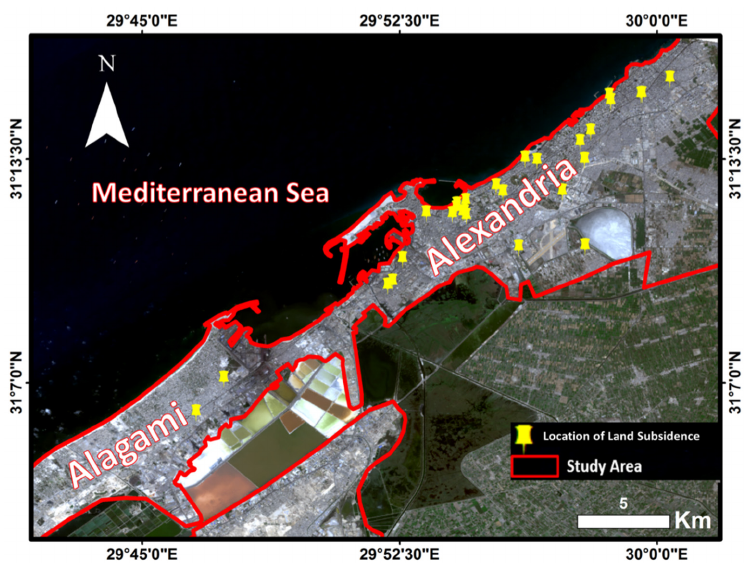
Figure 1. The urban study area in Alexandria City is outlined with a red border plotted on a Sentinel-2 image of October 2019. The yellow dots represent the recently recorded subsidence events.